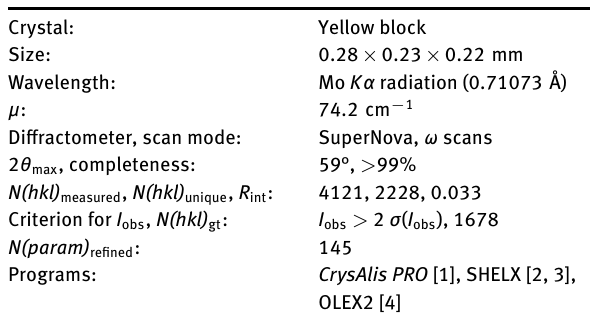
Table 1: Data collection and handling.